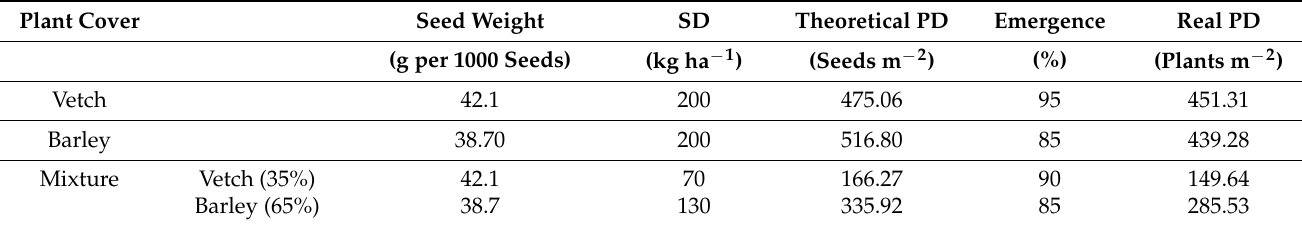
Table 2. Theorical and final plant